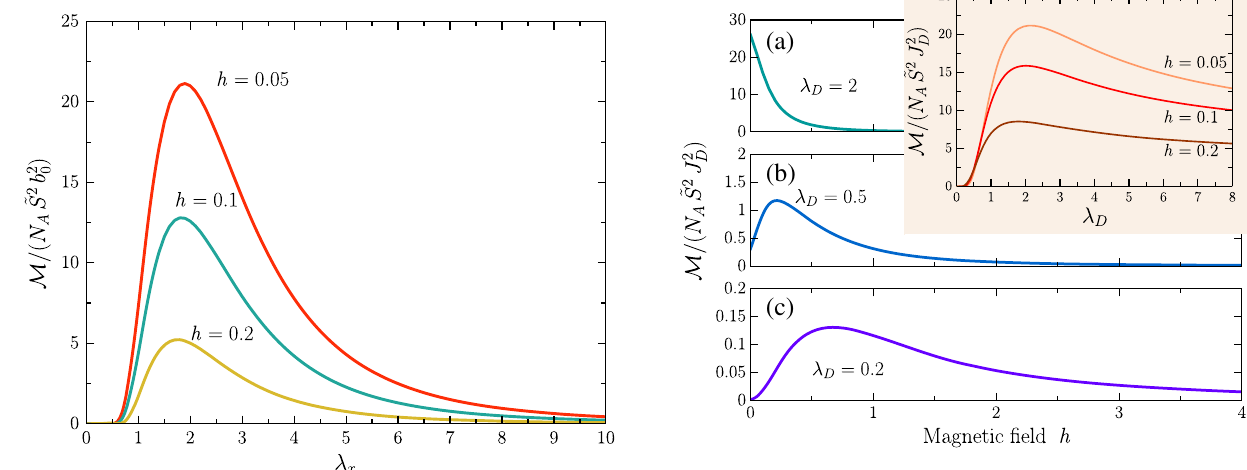
FIG. 4. Dependence of the mass term M on the trap size λ λ of an isotropic magnetic trap of strength b 0 ¼ 0 . 01 at T ¼ 0 . y The Skyrmion configuration is described by the parameters κ ¼ 0 . 7 , and three values of magnetic field h ¼ 0 . 2 , 0.1, 0.05 with Skyrmion radius λ ¼ 1 . 26 , 1.57, 1.79, respectively.